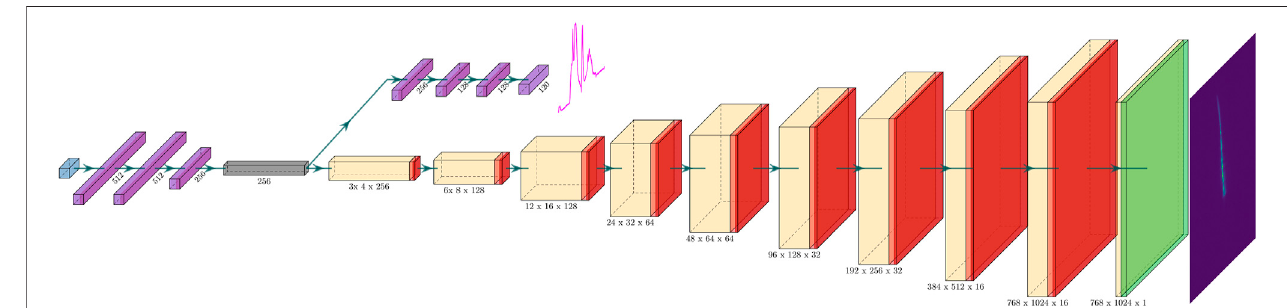
FIGURE 3 | Diagram of the encoder-decoder neural network. The leftmost blue box represents the input layer. It is followed by three fully-connected layers (encoder) in purple with each layer activated by the Leaky ReLU (Recti fi ed Linear Unit) function. The latent space is depicted in grey. The latent space leads to two decoder branches. One consists of several fully-connected layers with each layer activated by the Leaky ReLU function. The other consists of ten transposed convolutional layers in yellow. Each transposed convolutional layer is followed by a batch normalization layer and activated by the leaky ReLU function except the last one, which is activated by the sigmoid function depicted in green. The kernel sizes of the fi rst and second transposed convolutional layers are 3 × 4 and 3 × 3, respectively, and the kernel sizes of the other eight transposed convolutional layers are all 5 × 5. The total number of trainable parameters is 2,096,681 with 6 input parameters.